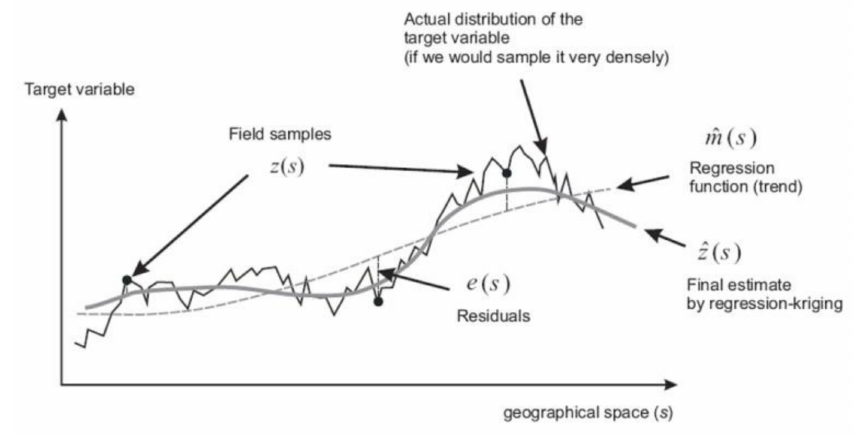
Figure 2. An example of the regression-kriging approach shown by means of a cross-section of the spatial random field (after Hengl,